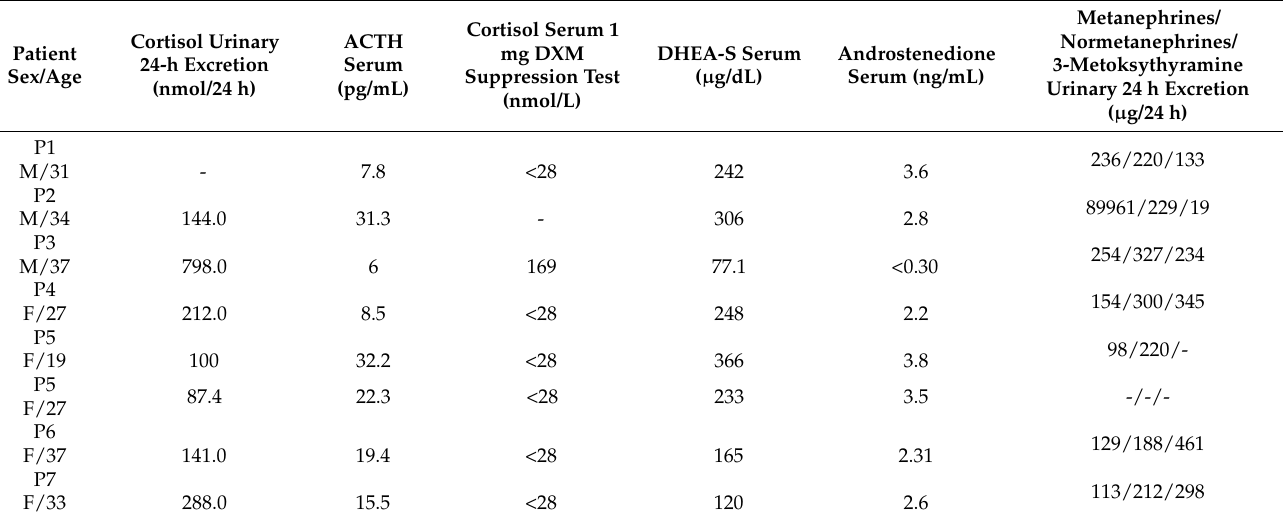
Table 1. Patient’s hormonal activity characteristics.